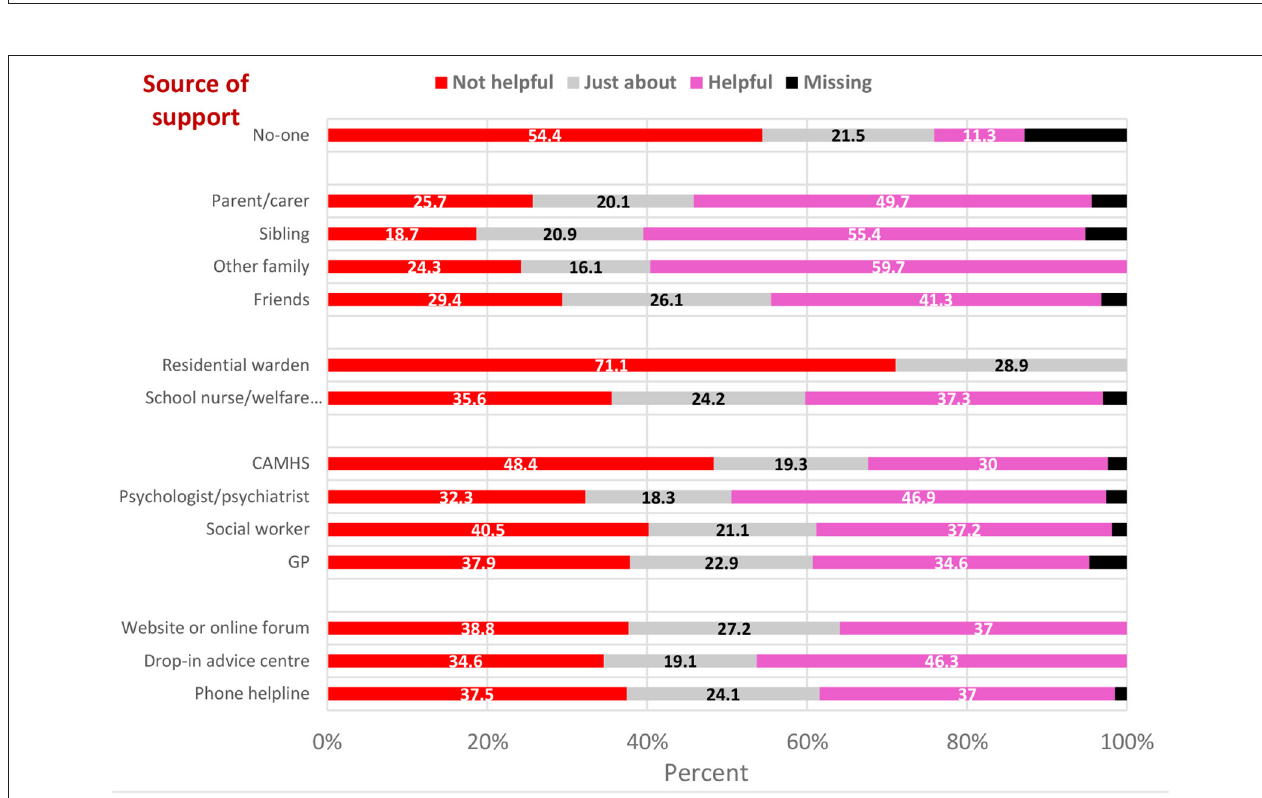
FIGURE 3 | Level of satisfaction with support received by source of support, weighted proportions a . a Weighted to account for differences in the distribution of selected sociodemographic variables between the study sample and the target population.